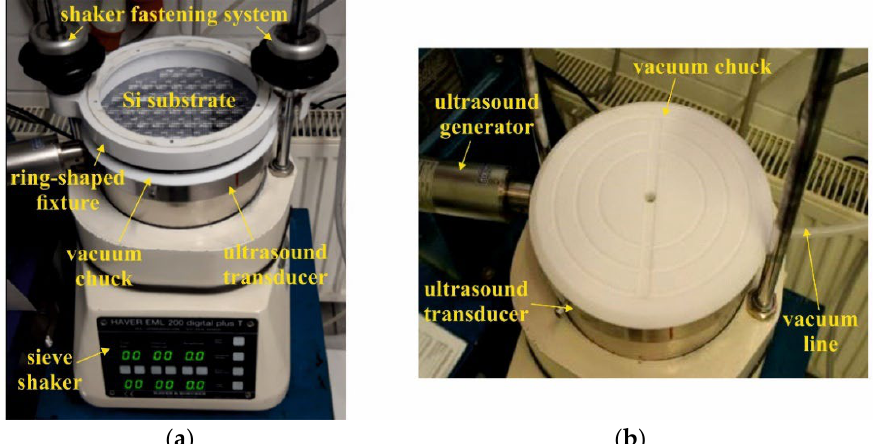
Figure 8. ( a ) Setup for automated micro mold filling consisting of a sieve shaker and a custom-built clamping unit with mounted substrate. The clamping unit comprises a vacuum chuck with integrated ultrasound transducer and a ring-shaped cover. In ( b ) the clamping unit is shown without cover and substrate.